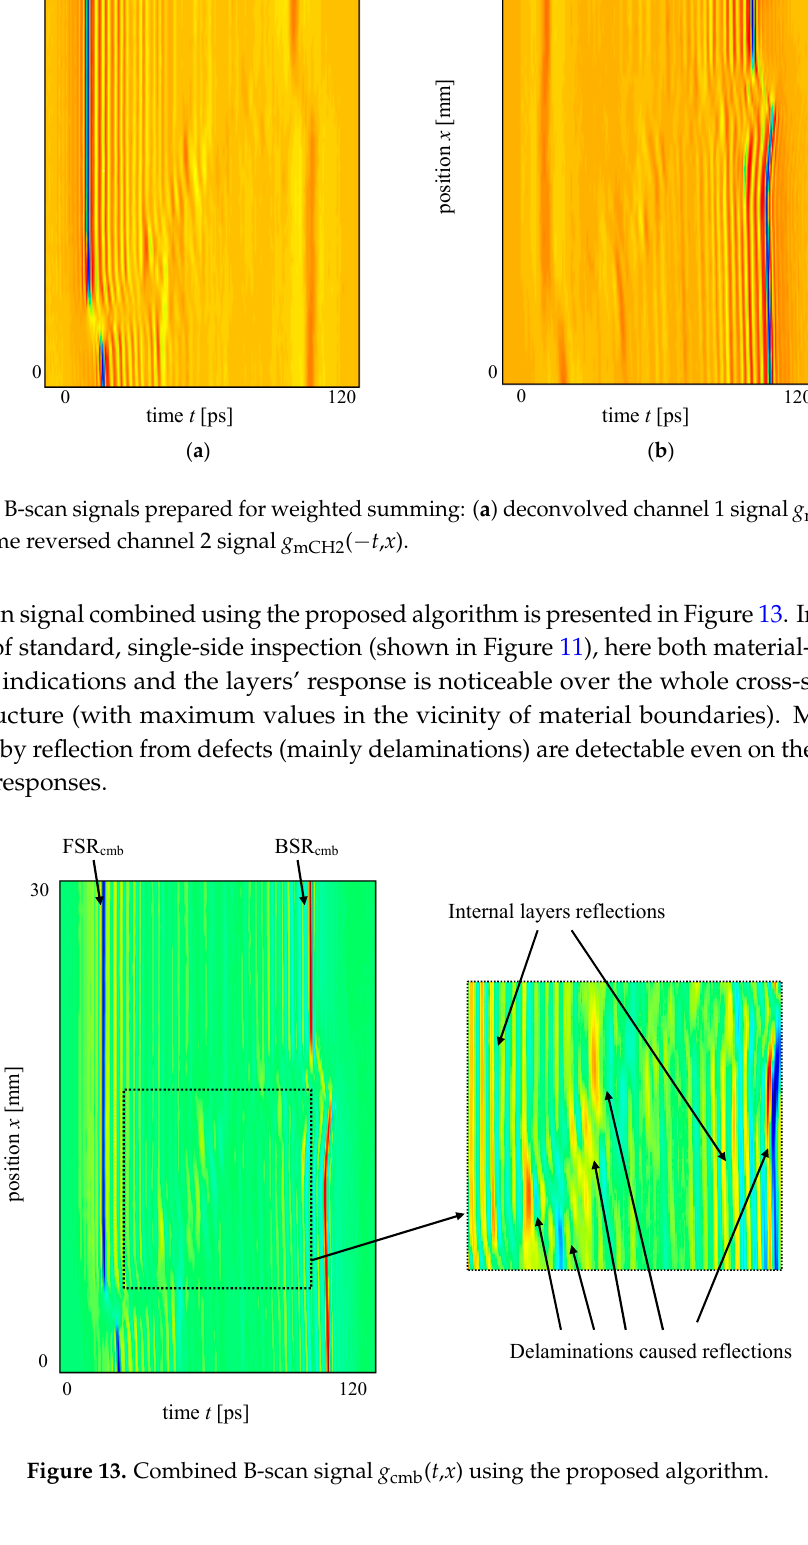
Figure 11. Exemplary B-scan signals obtained using double-sided inspection of a composite sample subjected to stress: ( a ) deconvolved channel 1 signal g mCH1 ( t , x ); and ( b ) deconvolved channel 2 signal g mCH2 ( t , x ).